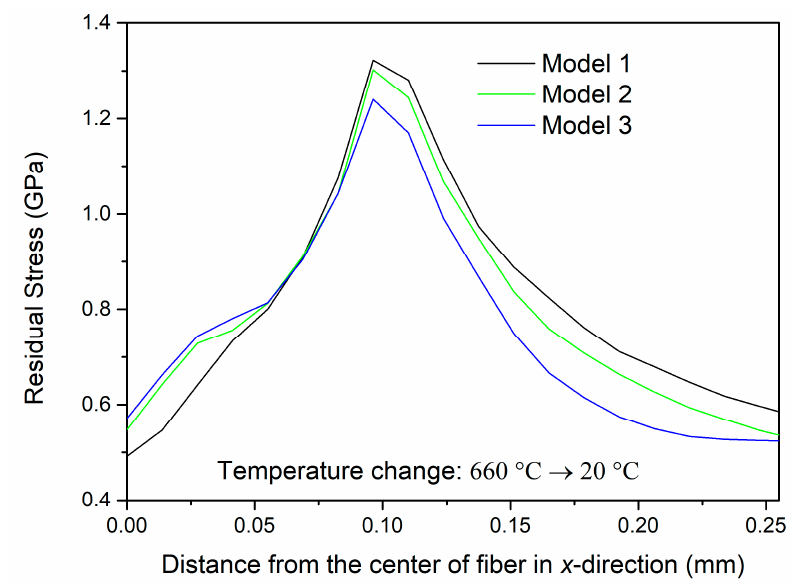
Figure 10. Compressive residual stress distribution for the composites (Model 1, 2 and 3) along the x direction at y = z = 0 mm . direction at y = z = 0